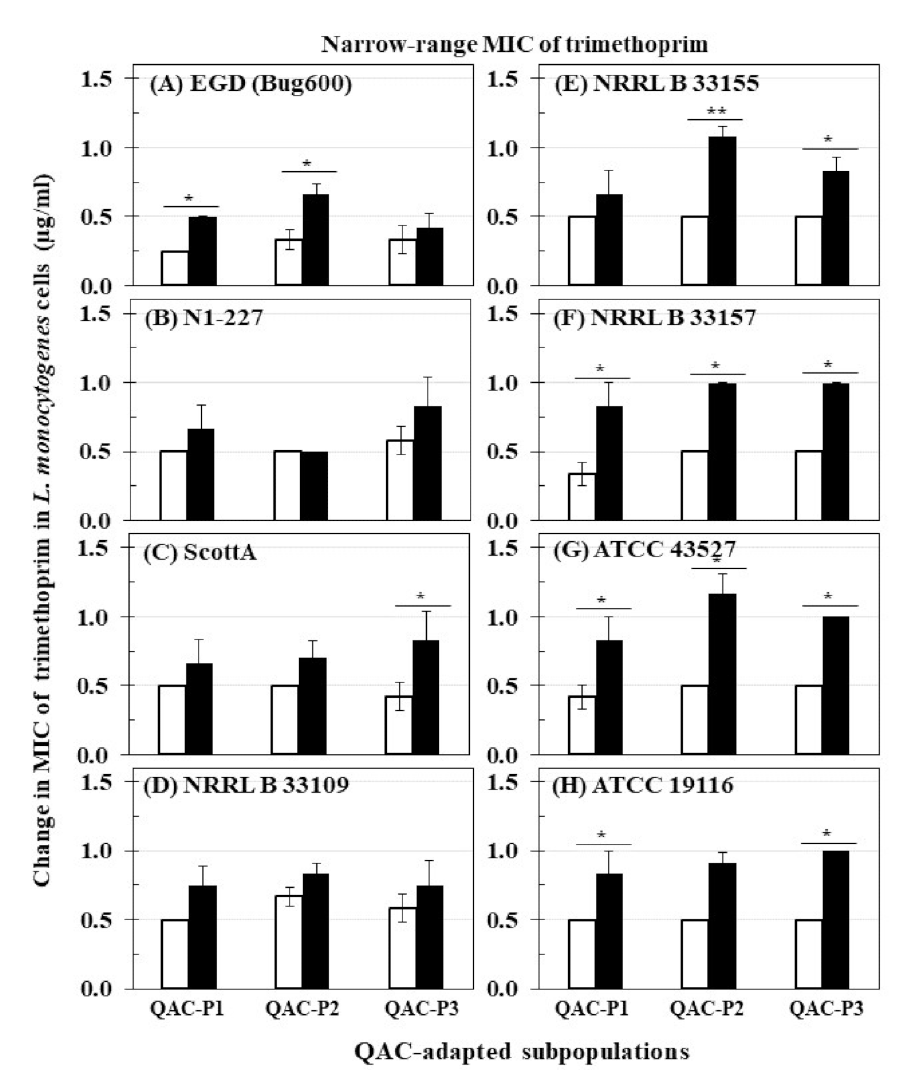
Figure 1. Changes in minimum inhibitory concentration (MIC) of trimethoprim ( µ g/mL) for QAC- adapted subpopulations (closed bars) compared to non-adapted controls (NAc) (open bars) of eight L. monocytogenes strains: ( A ) EGD (Bug600), ( B ) N1-227, ( C ) ScottA, ( D ) NRRL B 33109, ( E ) NRRL B 33155, ( F ) NRRL B 33157, ( G ) ATCC 43527, ( H ) ATCC 19116. Error bars indicate standard errors of means. Statistically significant p values are indicated by asterisks (*, p < 0.05; **, p < 0.01) that were obtained using the unpaired two-tailed t